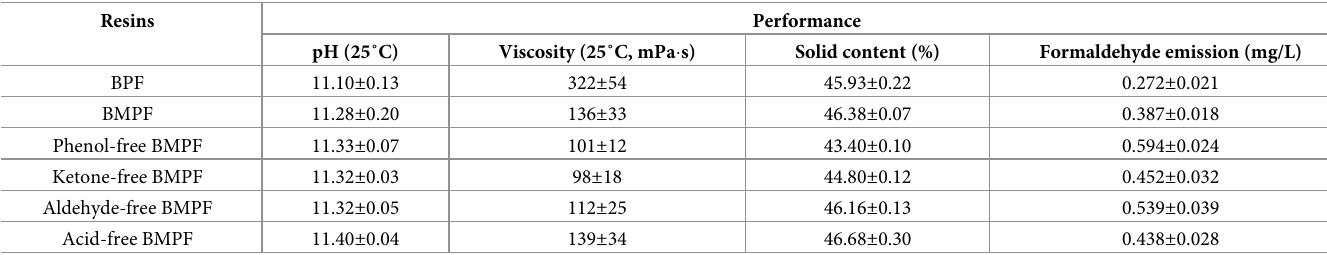
Table 6. Characteristics of